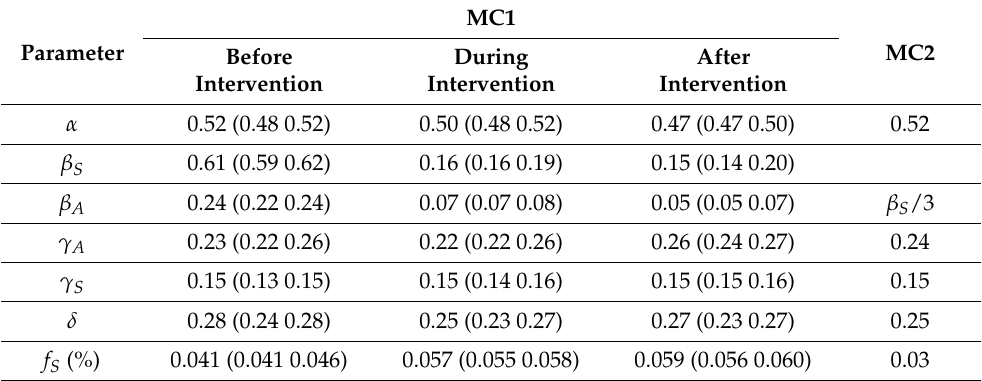
Table 3. Posterior distributions of the optimum model parameters (1/day). The numbers in paren- thesis denote the interquartile range (IQR) of the 0.5th percentile. Values before, during and after the intervention (MC1: 15/02/2020–31/05/2020). The values in the last column are used in the MC2 runs (15/02/2020–15/12/2020).